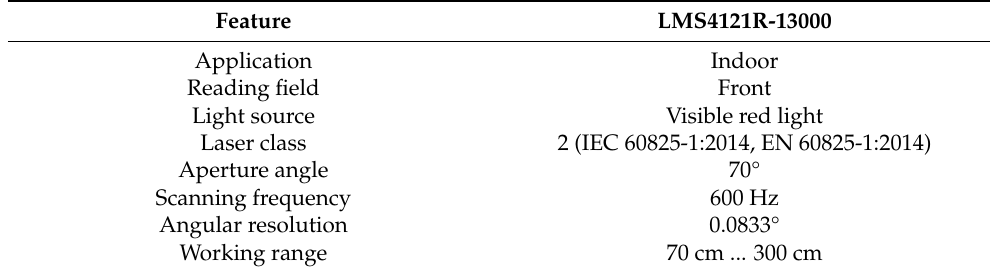
Figure 1. Illustration of the proposed platform based on a LiDAR sensor and a turntable for 3D plant reconstruction. ( a ) Frontal view, ( b ) Isometric view, ( c ) Top view, ( d ) Lateral view. Table 1. Main features of LiDAR